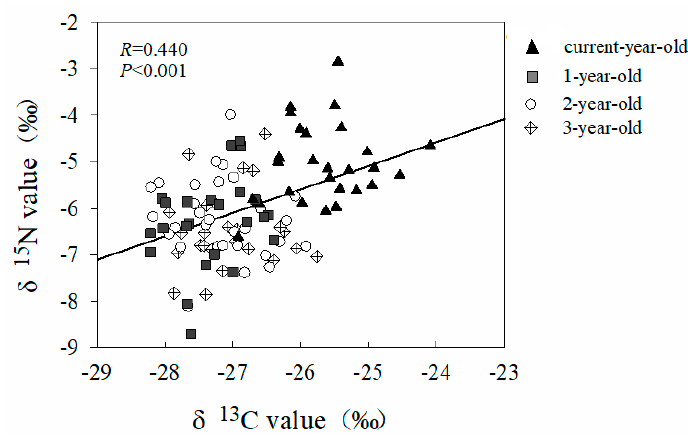
Figure 5. Relationship between leaf δ 13 C and δ 15 N values of P . crassifolia . Leaf ages (current year leaves: triangles; 1-year-old leaves: squares; 2-year-old leaves: circle; 3-year-old leaves: rhombic) are also given.